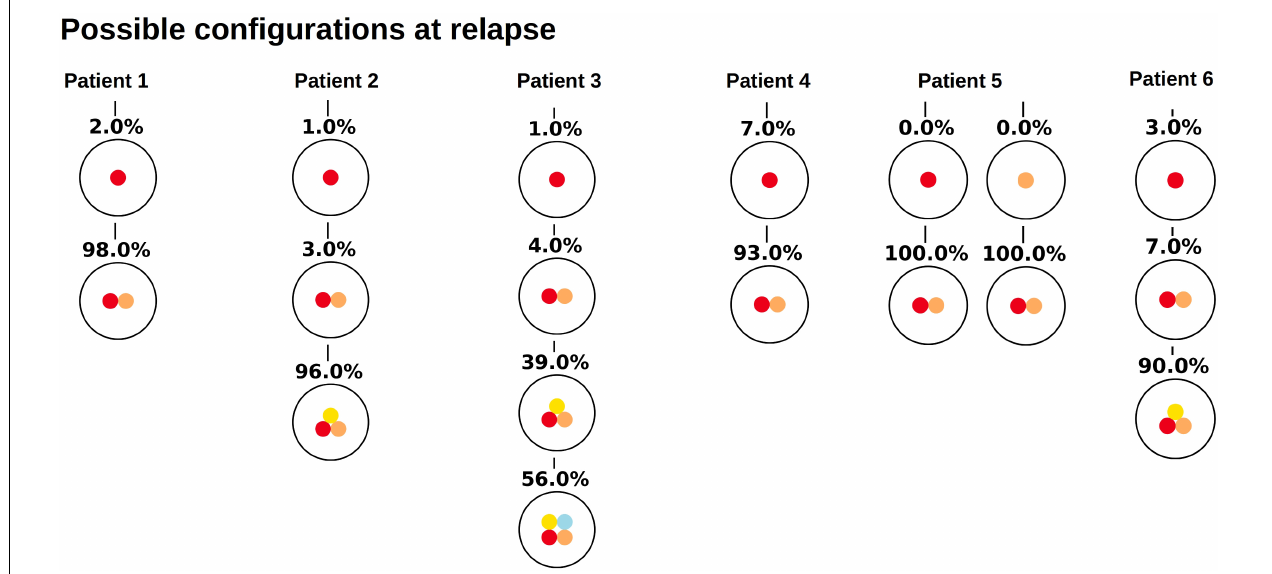
FIGURE 3 | Clonal hierarchies compatible with the bulk allele frequencies measured at relapse. For each considered patient, the figure shows which clonal hierarchies are compatible with the bulk variant allele frequencies measured at relapse. The root of the tree corresponds to the founder mutation. We observe that in most cases the hierarchies are